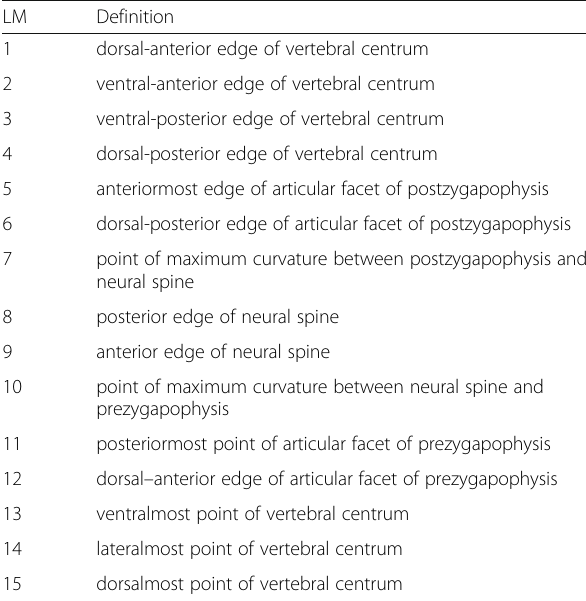
Table 1 Definition of landmarks (LM) applied to 3D scans of the mouse